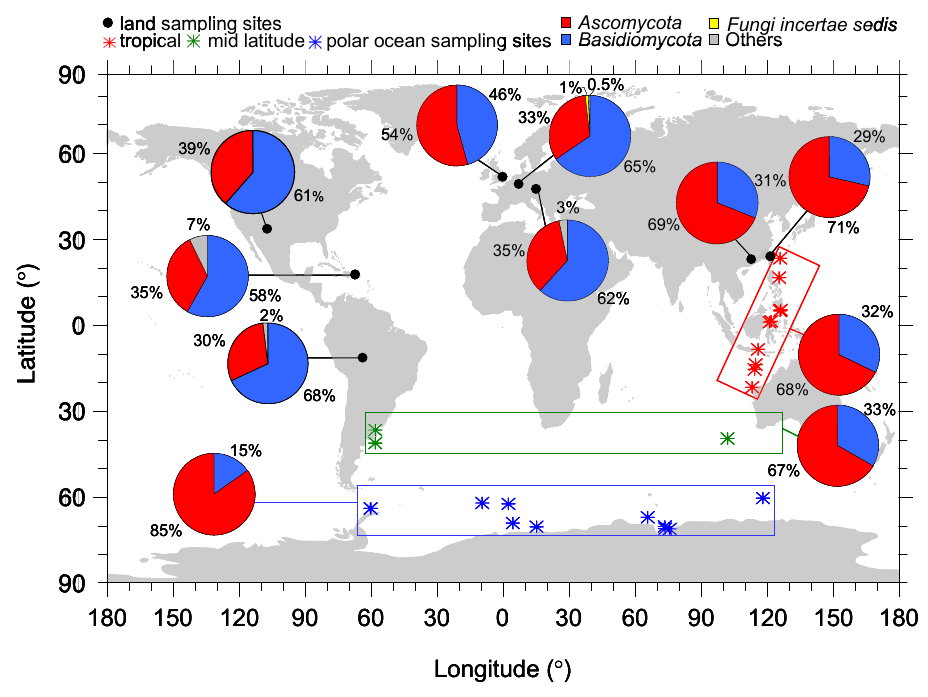
Fig. 1. Geographical location and relative proportions of different phyla in continental, coastal, and marine (ocean) sampling locations. the coarse-particle aerosol samples (13 samples and 1 blank sample) were